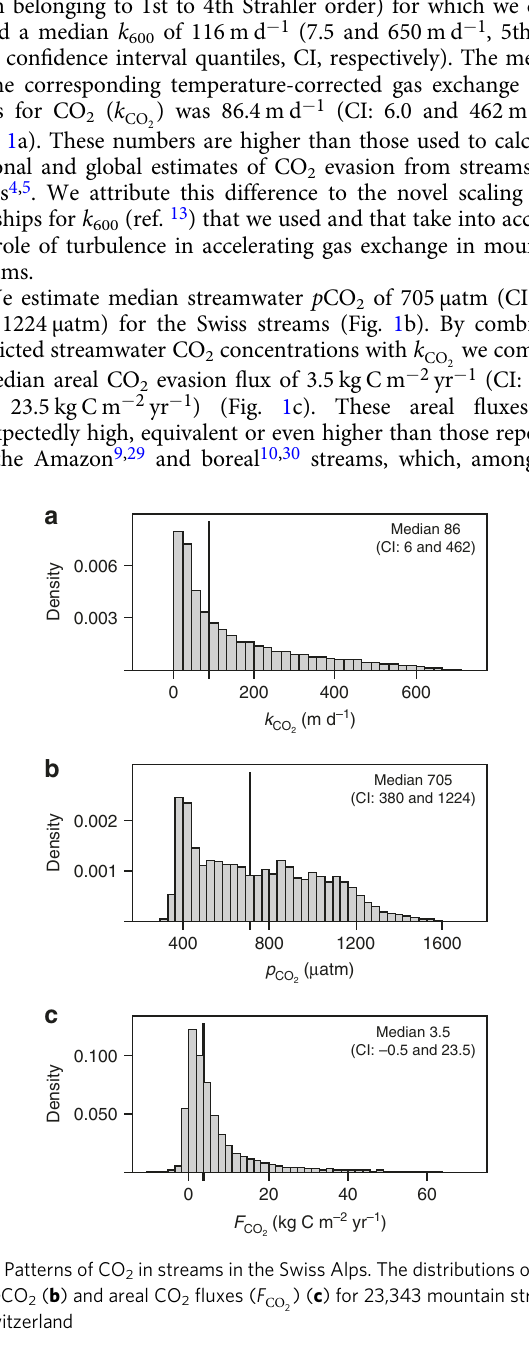
) ( c ) for 23,343 mountain CO 2